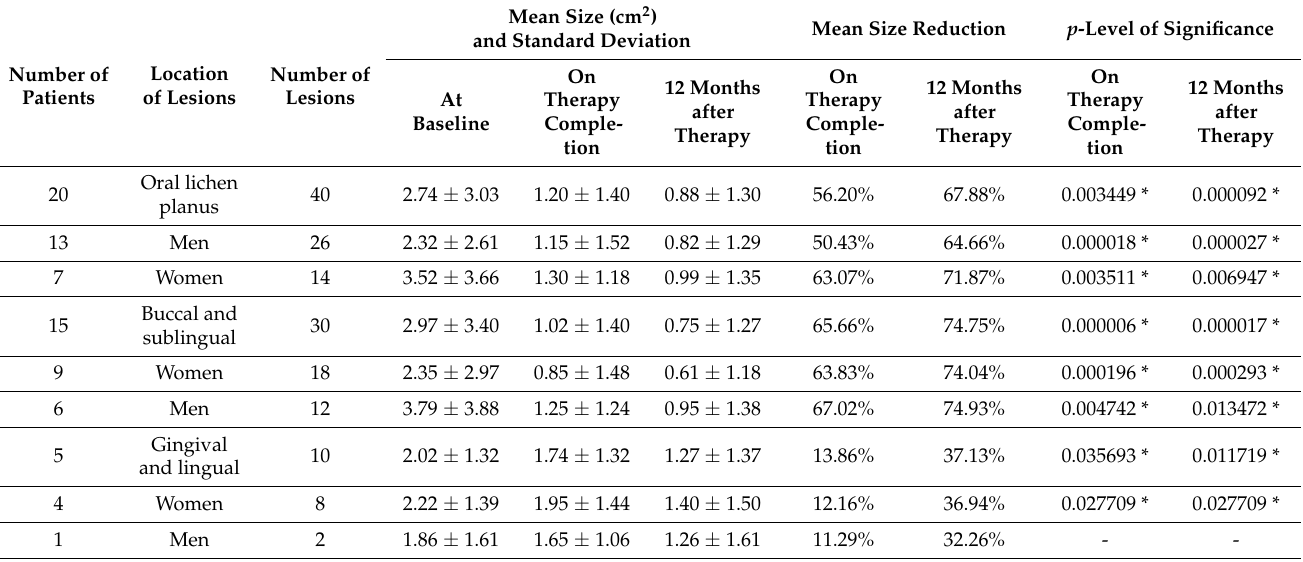
Table 1. Mean size, standard deviation, and mean reduction in OLP lesions at relevant stages of